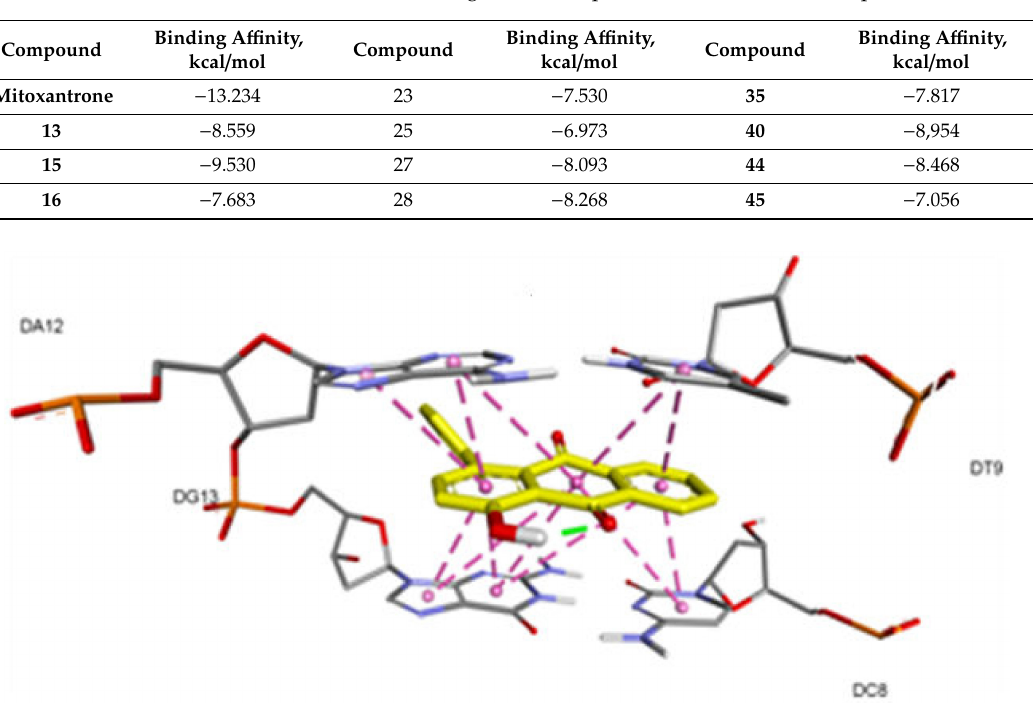
Table 2. Results of molecular docking with the topoisomerase II β -DNA complex.